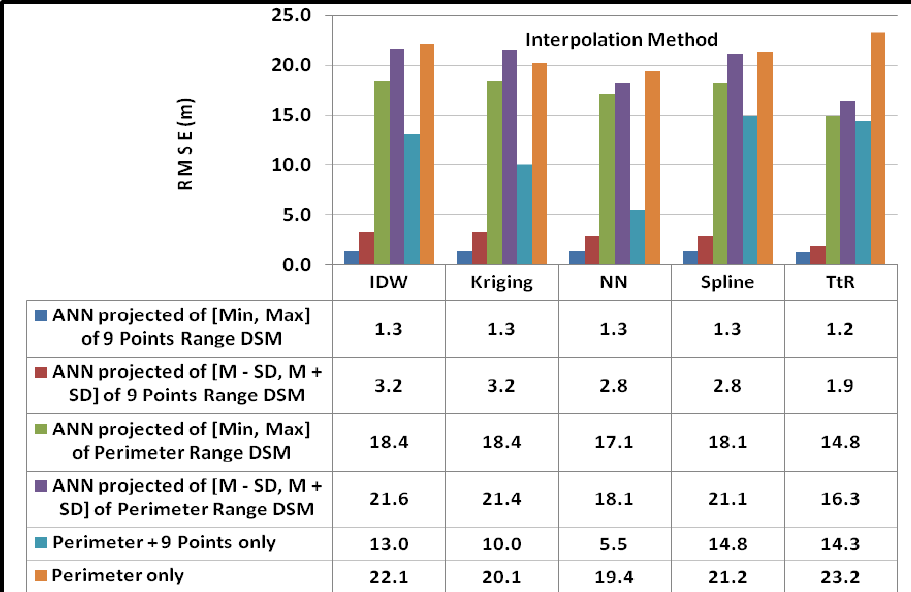
Figure 8. Accuracy comparison of finally generated different